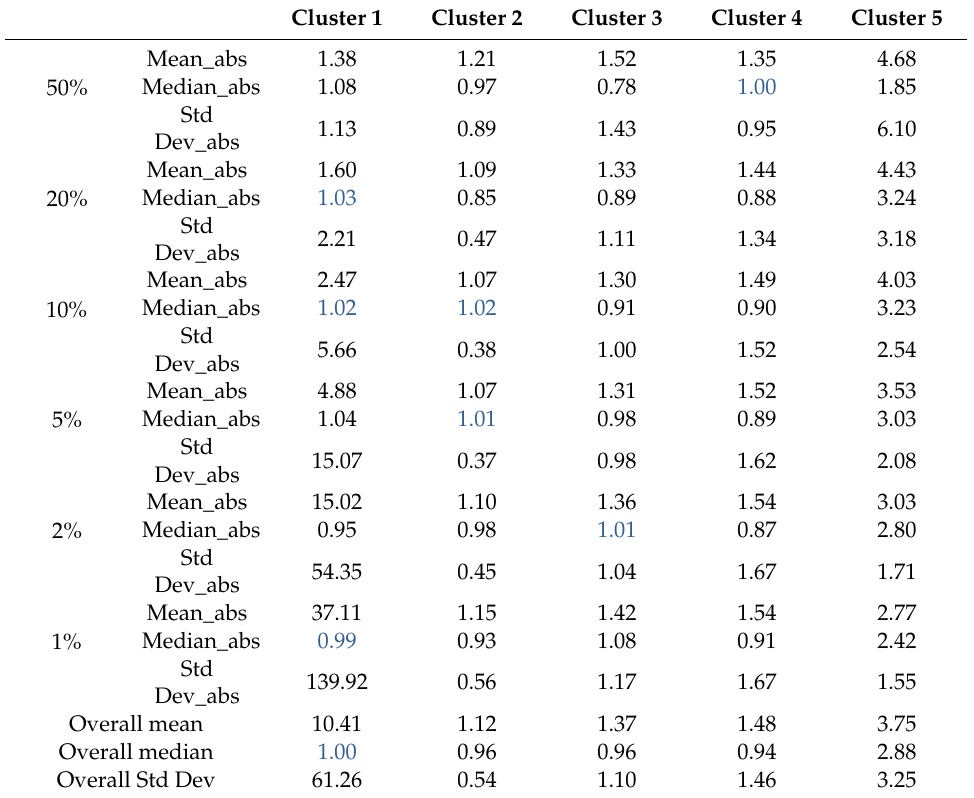
Table 11. Comparison of mean, median and standard deviation of Q pred / Q obs ratios for all five clusters (blue indicates the lowest